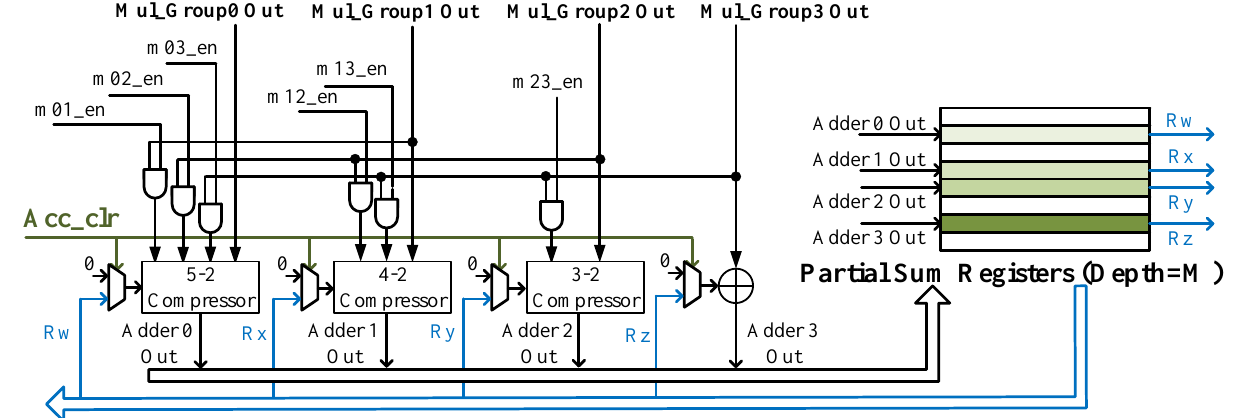
Figure 5. Details of the Compressor Adders and Selected Accumulators in the SPEC for output- channel-wise N : M sparse